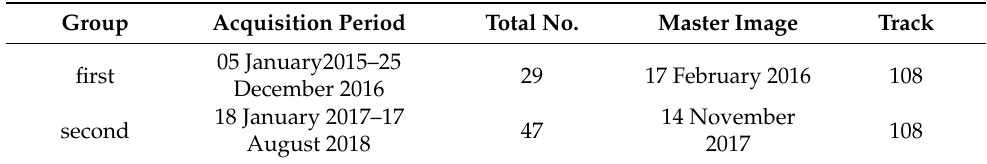
Table 2. Details of the analyzed